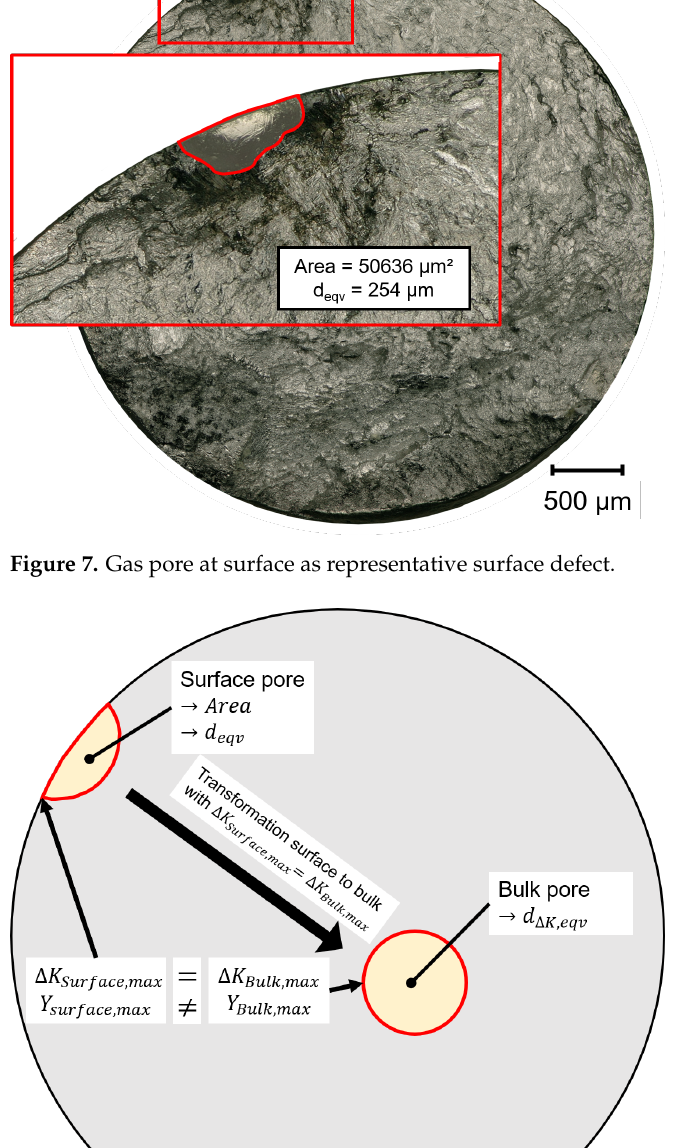
bulk pores, the distribution fit was performed for two datasets. The first dataset is the original data without transformation and the second dataset is the ∆ K eqv modified set